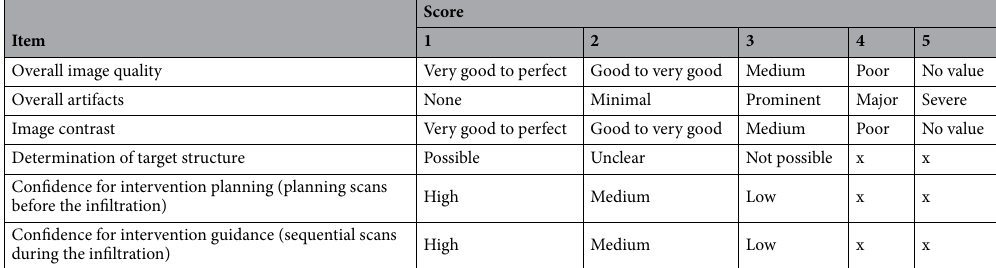
Table 2. Semi-quantitative scoring for image evaluation by two